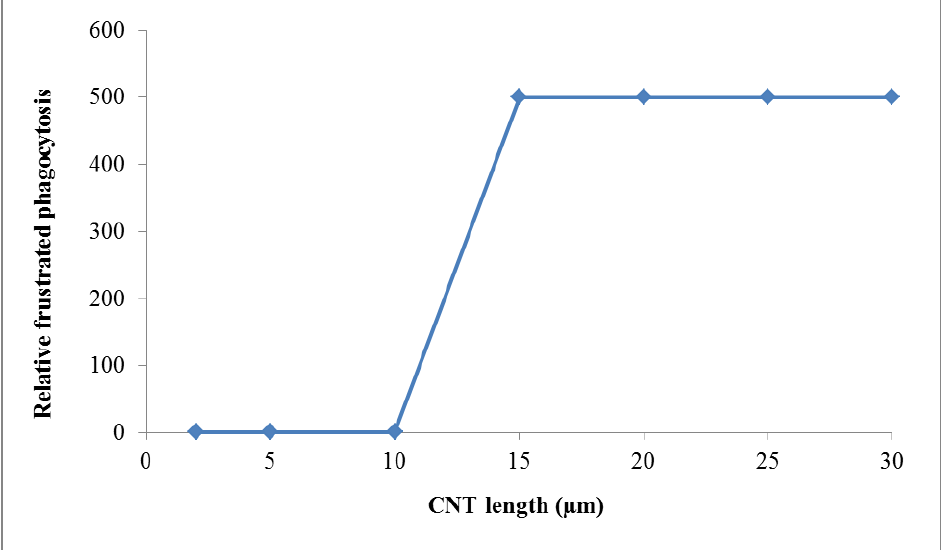
Figure 4. Weighting factor 4 ( w ) for particle morphology is proportional to frustrated PC,4 phagocytosis of intratracheally instilled biopersistent and long carbon nanotubes (CNT): for normal phagocytosis w is set to 1 while the w is set to 500 for enhanced PC,4 PC,4 frustrated phagocytosis of CNT longer than 15 μm. We consider the risk of cancer induction and the risk of subsequent death as a most threatening event such that we